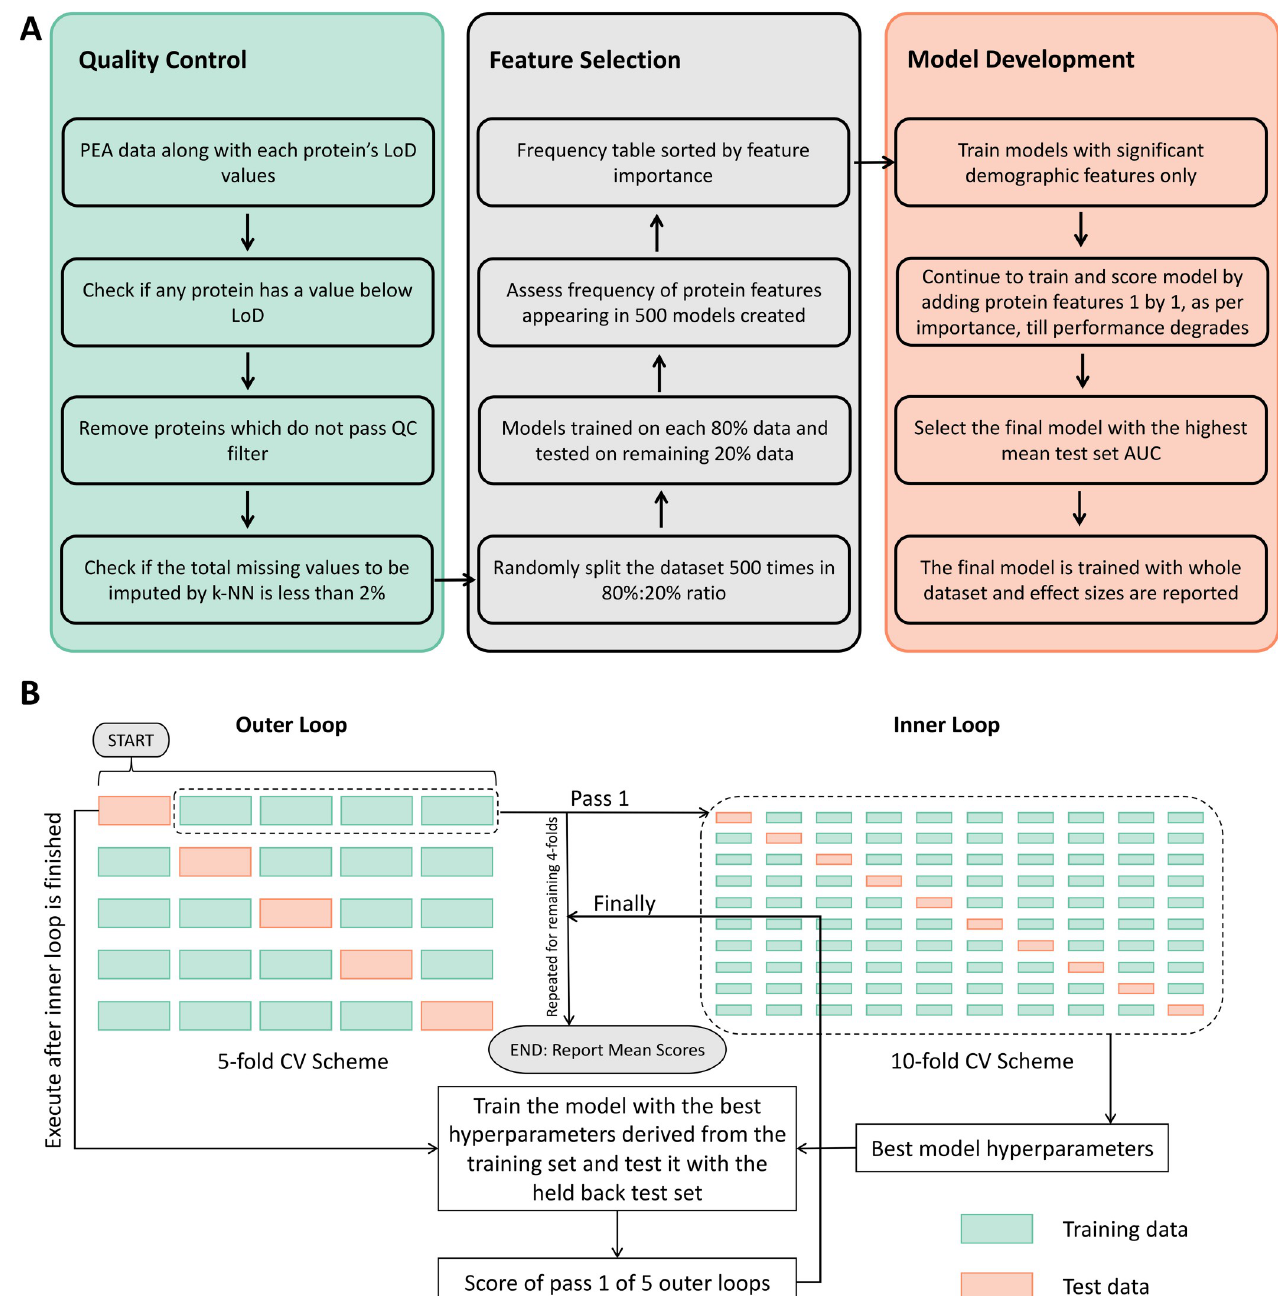
Fig 2. (A) Computational pipeline for the development of plasma protein signature. PEA = Protein Expression Analysis, LoD = Limit of Detection, QC = Quality Control, k-NN = k Nearest Neighbour, AUC = Area Under the Curve. (B) The Machine Learning (ML) schema. 5-fold nested cross-validation (CV) followed for building the classifier for response to anti-tumour necrosis factor (anti-TNF) treatment in rheumatoid arthritis (RA)